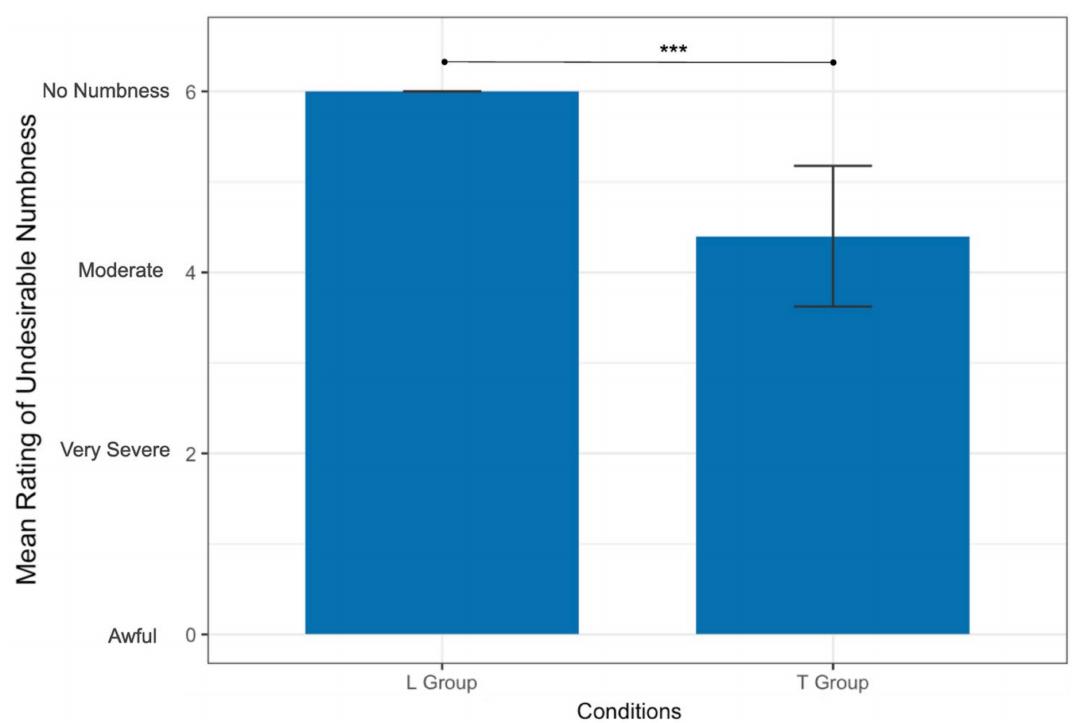
Figure 4. Illustrates the mean ratings of taste with associated standard deviation for both groups where 0 represents awful and 6 represents no taste perception. Abbreviations: T Group: 20% benzocaine topical gel + placebo laser; L Group: photobiomodulation + placebo gel. [***] represents significance at the p < 0.001 level.